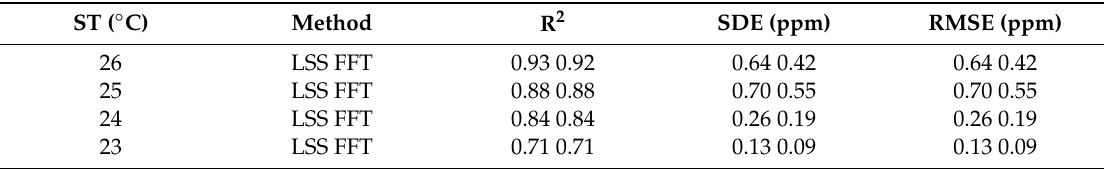
Table 4. Goodness of fit of the daily evolution of NH 3 concentrations to a sinusoidal curve at di ff erent setpoint